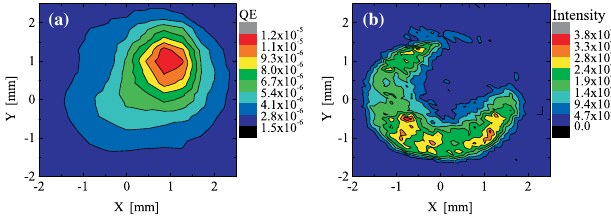
FIG. 10. QE map after rf processing (a) and luminescence map